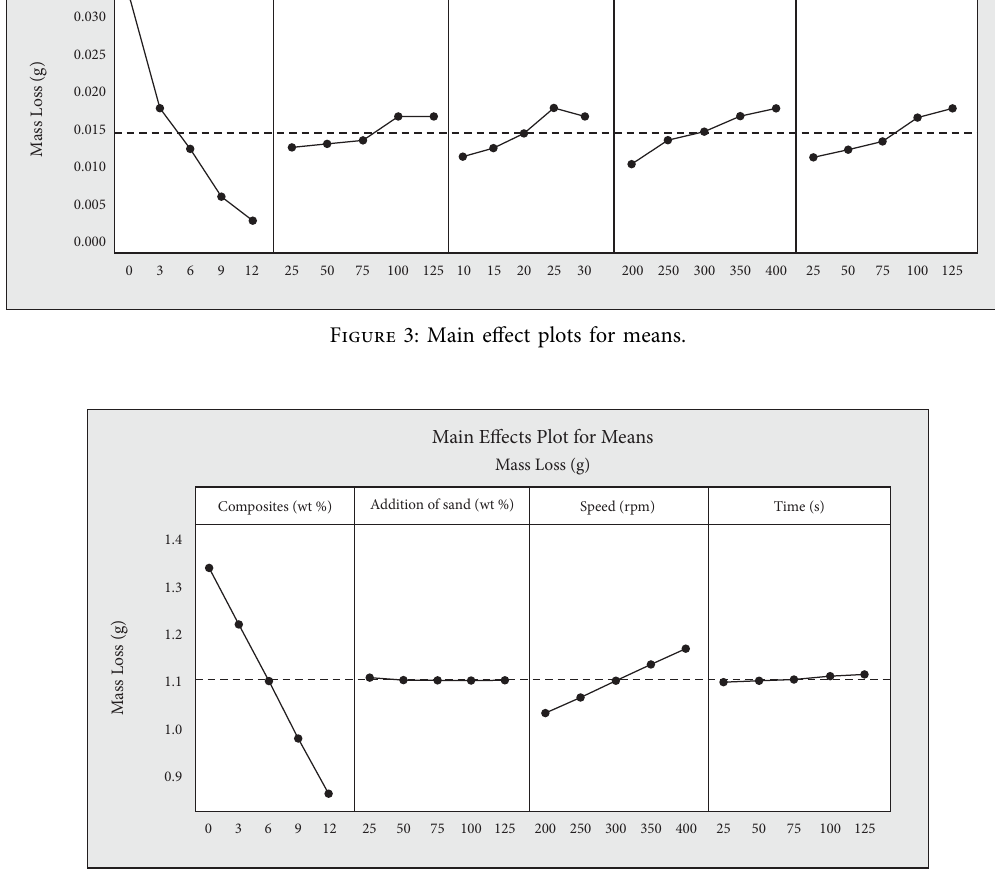
Figure 4: Main efect for the S/N ratio. Table 7: Mean’s response table (abrasive wear).